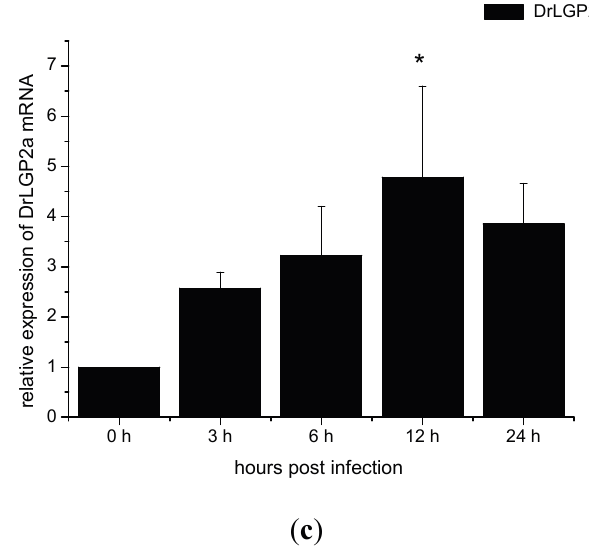
Figure 5. ( a ) The expression of DrLGP2a, DrLGP2b proteins during the infection with SHVV. The samples were harvested at 0, 3, 6, 12, 24 h post-infection and detected by Western blot. Expression of β -actin was used as the loading control .Molecular weight of DrLGP2a, DrLGP2b and β -actin was 77, 55, and 42 kD, respectively; ( b ) The